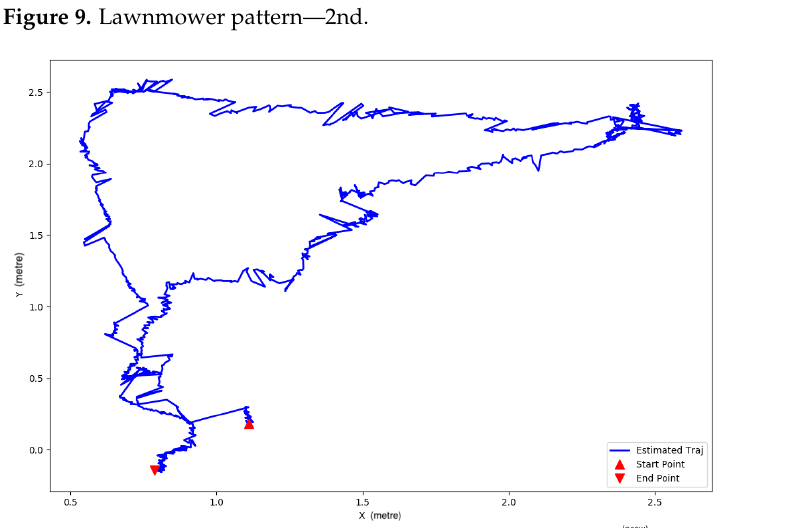
Figure 9. Lawnmower pattern—2nd.